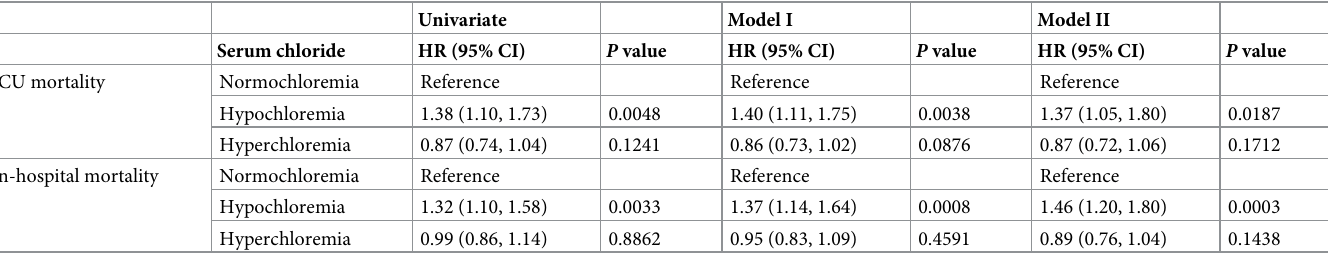
Table 2. Associations of time-varying serum chloride with in-hospital and ICU mortality.